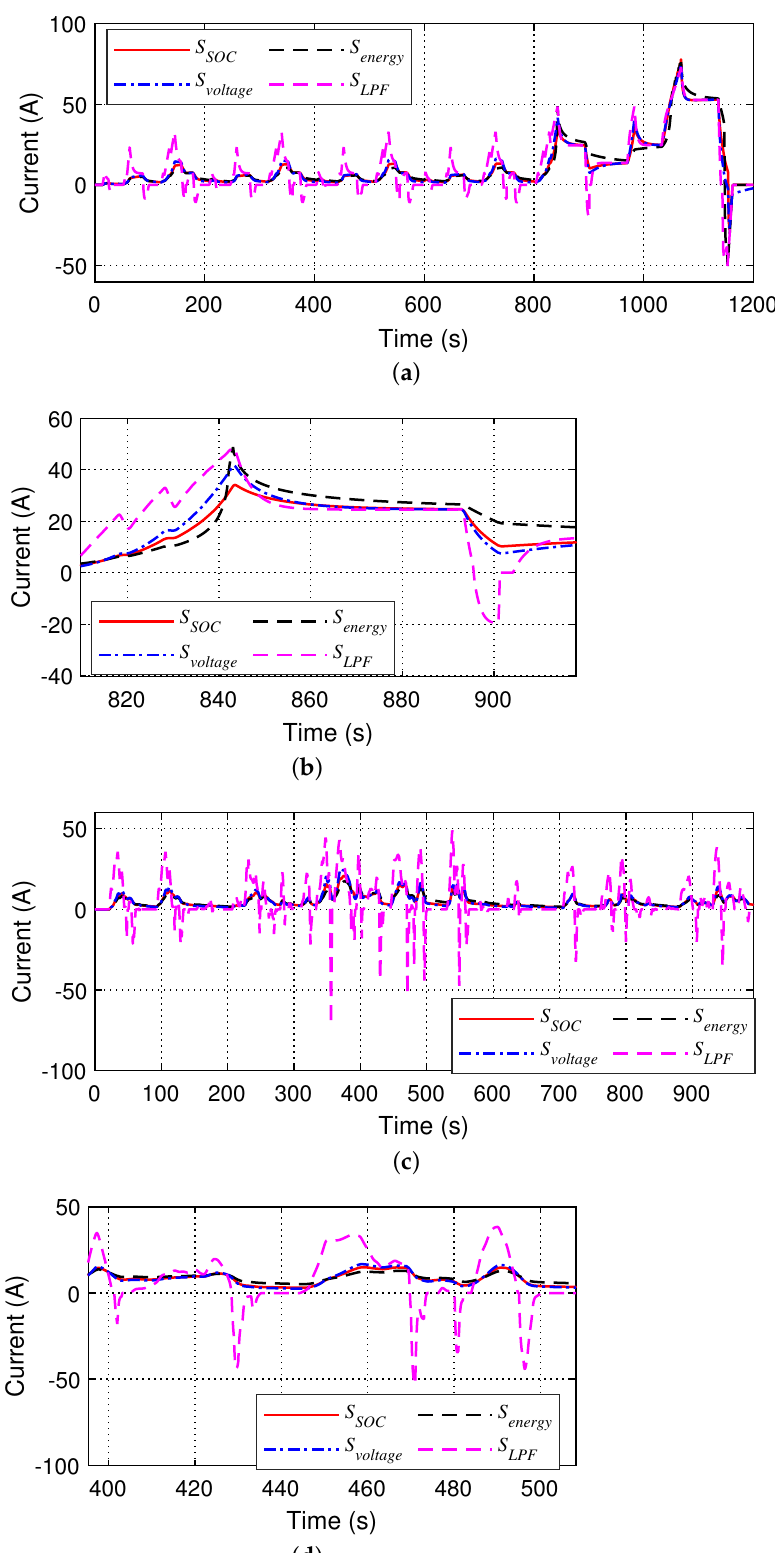
Figure 12. Battery currents with the EMS under two driving cycles: ( a ) Battery currents with the NEDC; ( b ) Zoom shape of battery currents with the NEDC; ( c ) Battery currents with the AUDC; ( d ) Zoom shape of battery currents with the